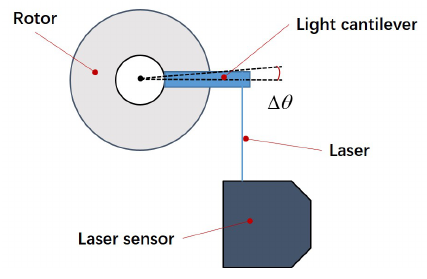
Figure 9. Principle of angular displacement